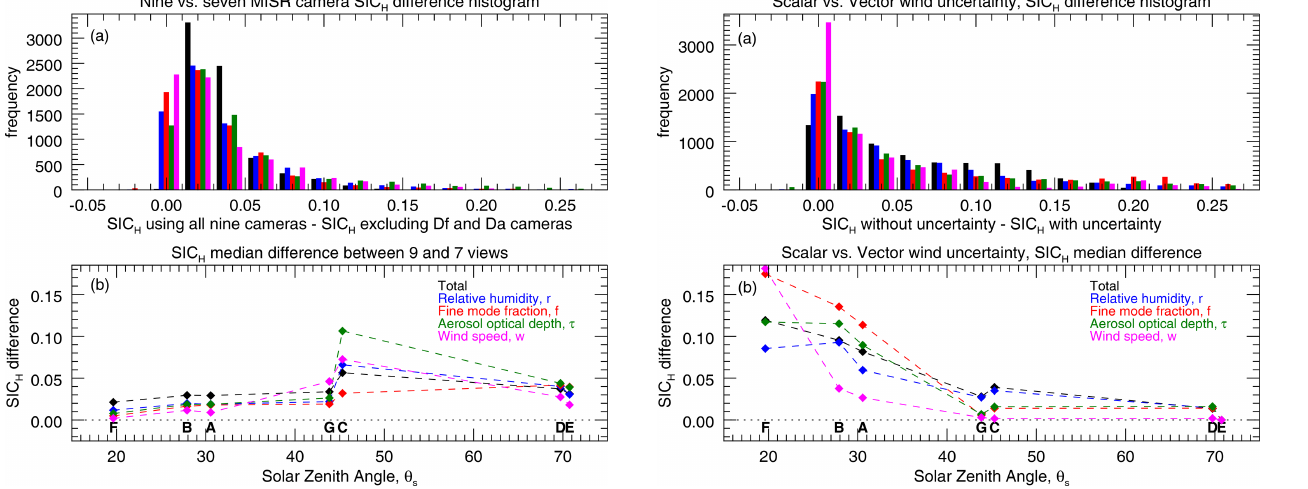
Figure 10. Test of the influence of the scalar versus vector treat- ment of wind speeds. Our parameterization scheme uses a scalar representation of wind speed, and the information content assess- ment incorporates an estimate of the model uncertainty due to this approach compared to the more complex vector winds. This figures shows the SIC H difference when using, or not using, that model uncertainty. Panel (a) contains the histograms of the SIC H with- out vector wind uncertainty minus the SIC H when that has been included. Universally positive values mean that vector wind model uncertainty does have an impact on the results. Panel (b) is the me- dian SIC H for each of the test cases. Here we see that the lowest- θ s cases, where the influence of sun glint is greater, are most sensitive to this model